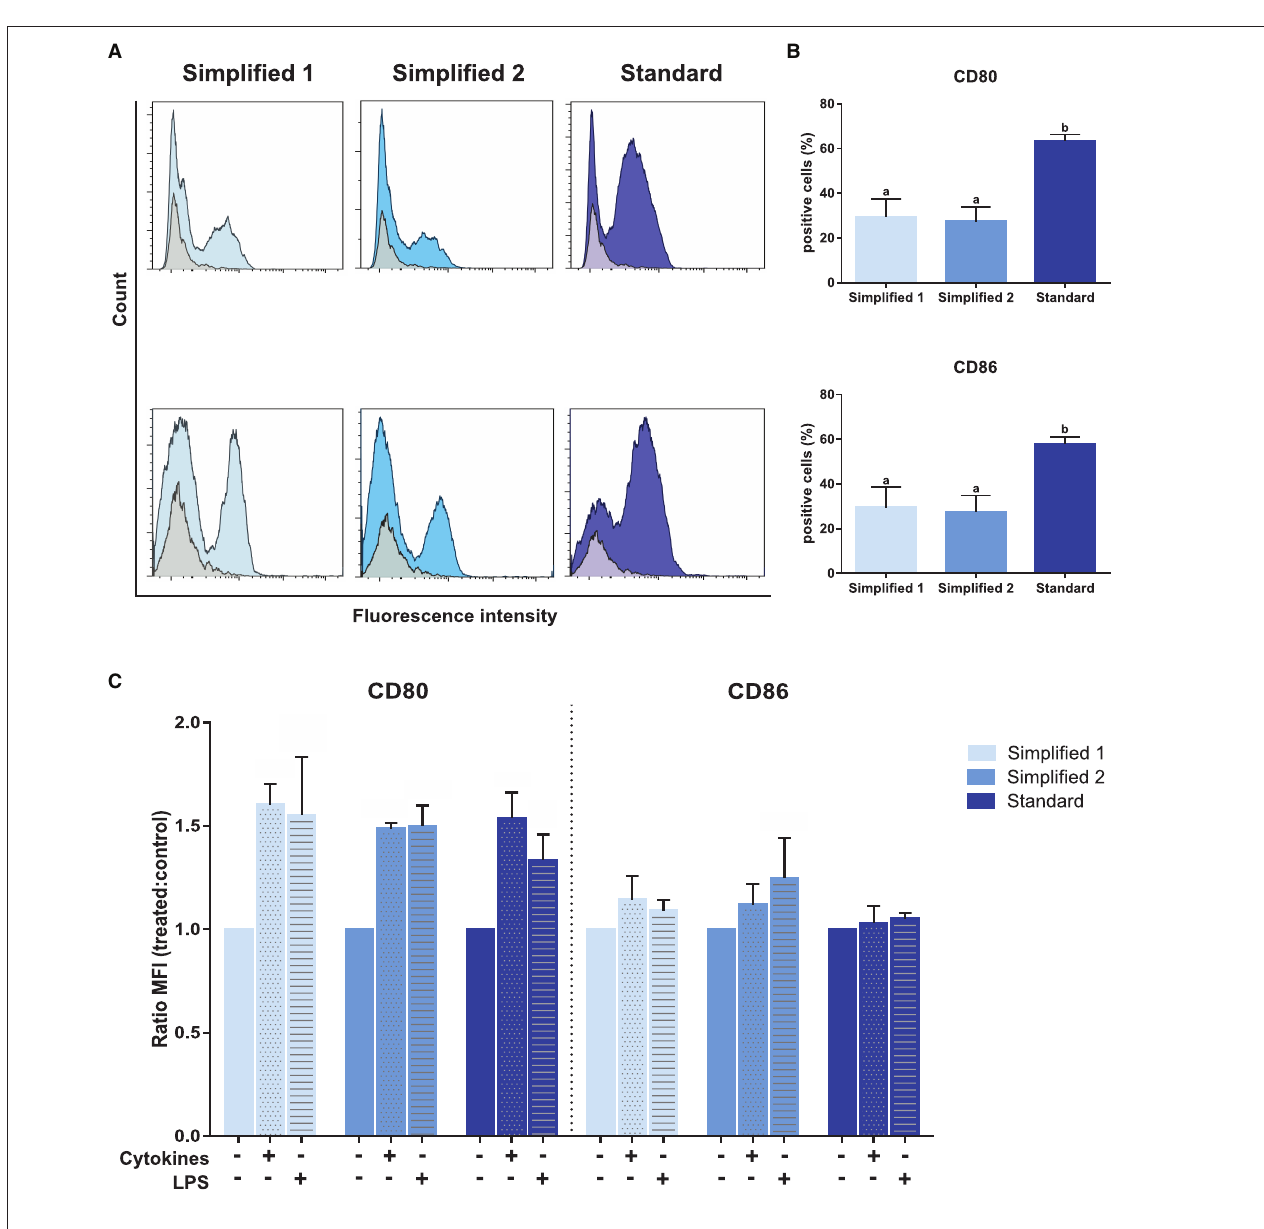
FIGURE 5 | Analysis of maturation and dendritic cells-specific surface markers. (A) CD80 and CD86 detection by flow cytometry. Gray and blue peaks correspond to isotype and marker-specific labeling, respectively. The histograms show the results of one representative experiment. (B) Bar plots depict the percentage of positive cells in three independent samples. Different letters represent mean statistically significant difference ( p < 0.05). (C) CD80 and CD86 MFI was analyzed after moDC treatment with a cocktail of cytokines [interleukin-6 (IL-6), interleukin-1 β (IL-1 β ), and interferon- γ (IFN- γ )] or lipopolysaccharide (LPS). Bars corresponding to non-treated controls are identified as cytokines and LPS negative. Ratio values of samples from three different animals were calculated as follows: cytokine-treated MFI/mock MFI or LPS-treated MFI/mock MFI. Error bars represent